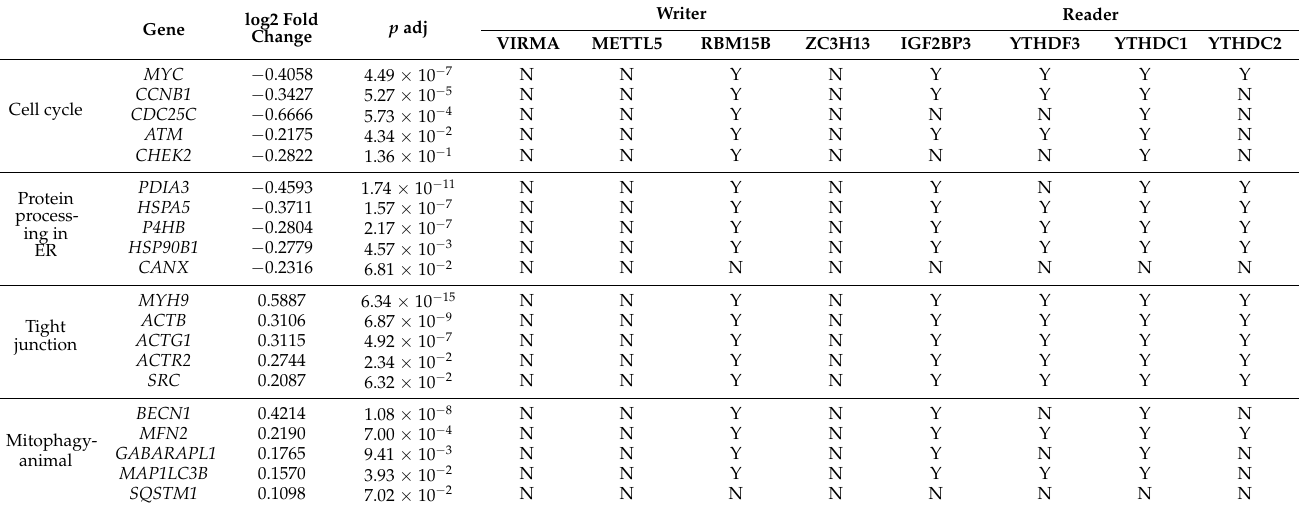
Table 1. The mRNA expression and their potential substrates of m6A regulators. log2 Fold Gene